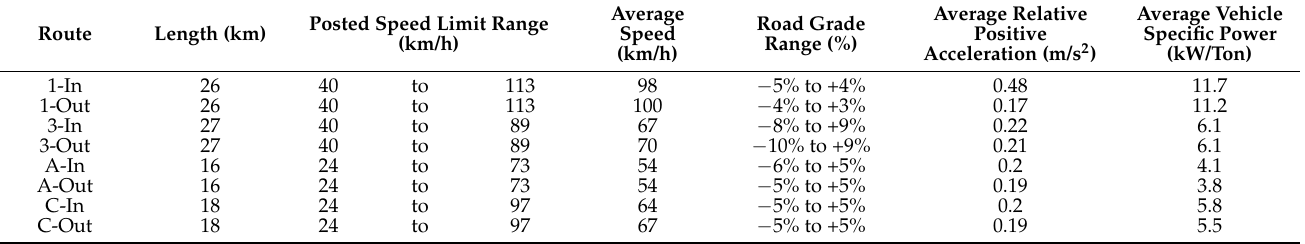
Table 2. Selected characteristics of inbound and outbound Routes A, C, 1, and 3 in Raleigh and the Research Triangle Park Area in North Carolina used for hot-stabilized operation